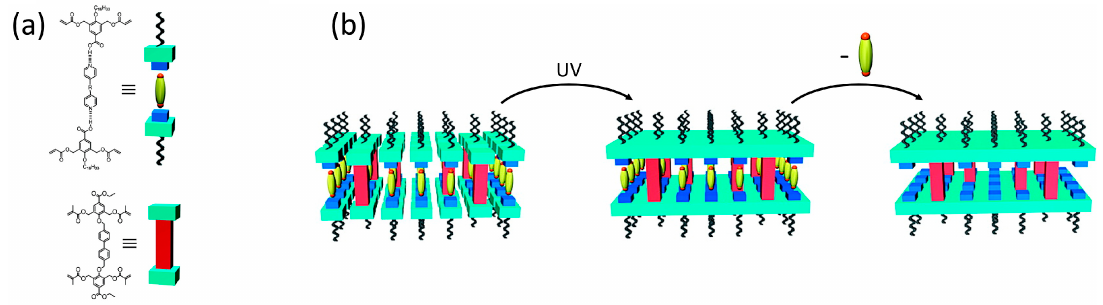
Figure 8. Smectic LC based nanoporous membrane. ( a ) Structures of the used supramolecular monomers; ( b ) Fixation of LC morphology via a UV curing step followed by the formation of the nanopores by removal of the dipyridyl template, a tetra-methacrylate ‘nanopillar’ was used to provide structure and layer integrity. Reprinted (adapted) with permission from [73]. Copyright 2008 American Chemical Society.